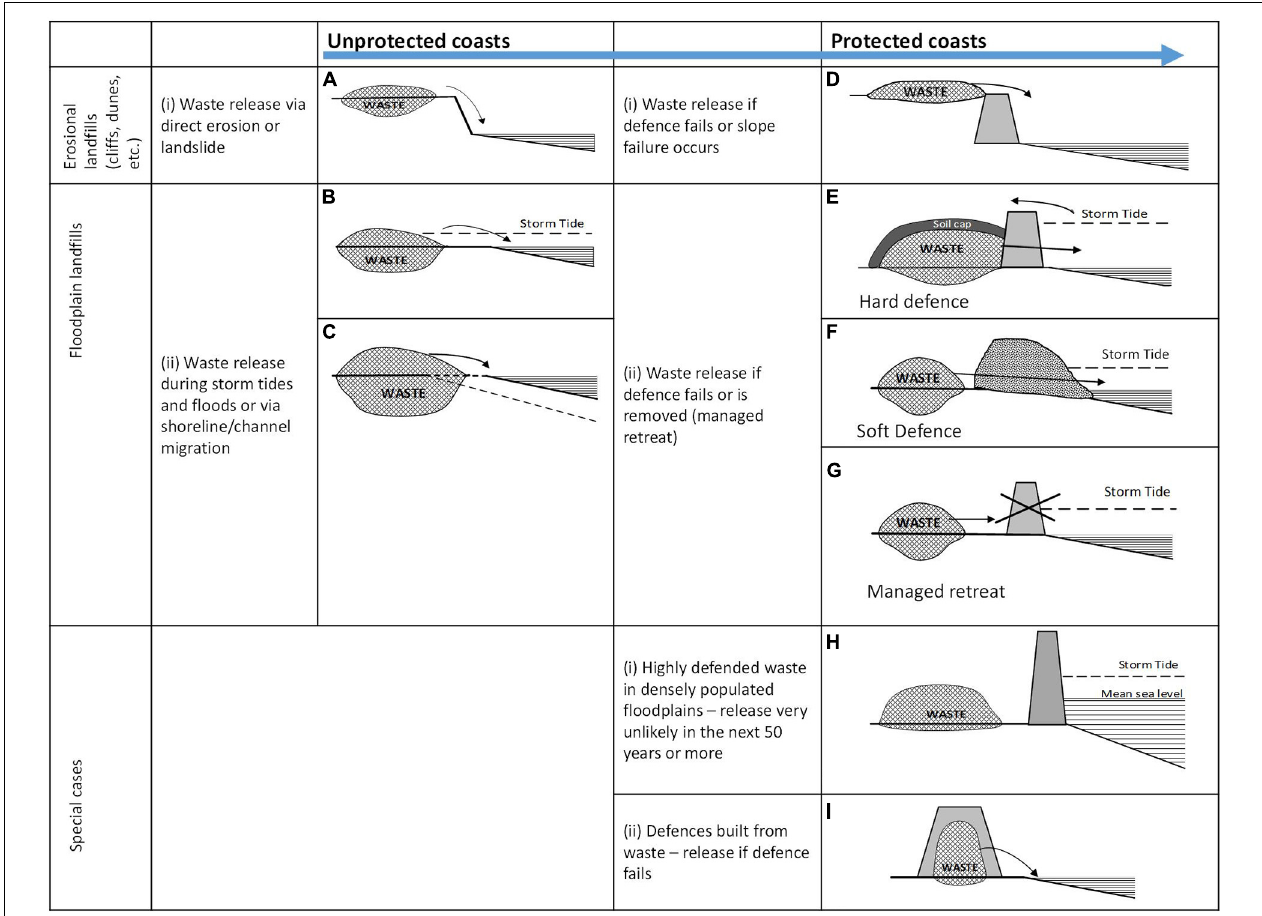
FIGURE 2 | The potential situations recognized in this paper where landfill materials can be released to the sea. The situations labelled (A) to (I) are described in the